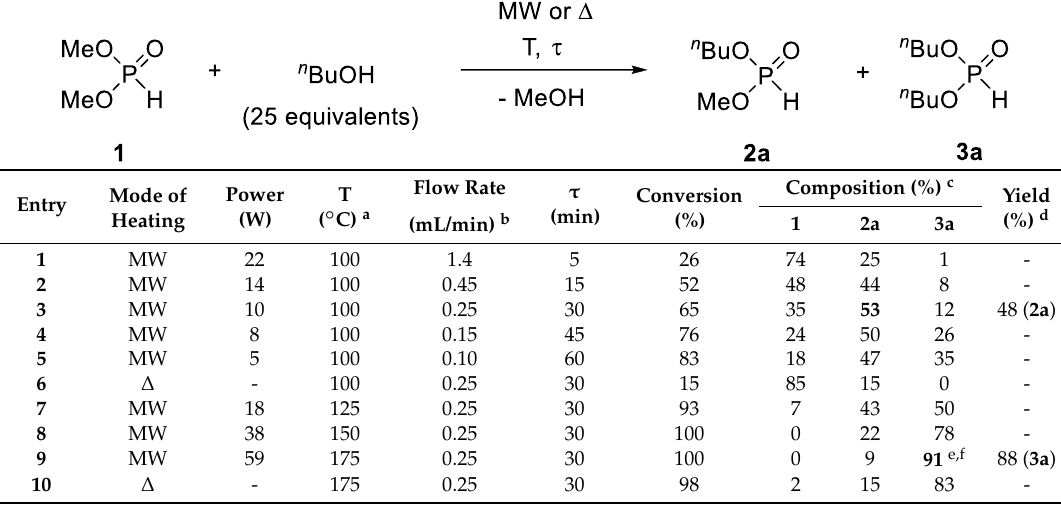
a The pressure was 17 bar; b Based on the HPLC pump; c the mixtures from the stationary operation were analyzed by GC; d after column chromatography; e No change on longer residence time (45 min);